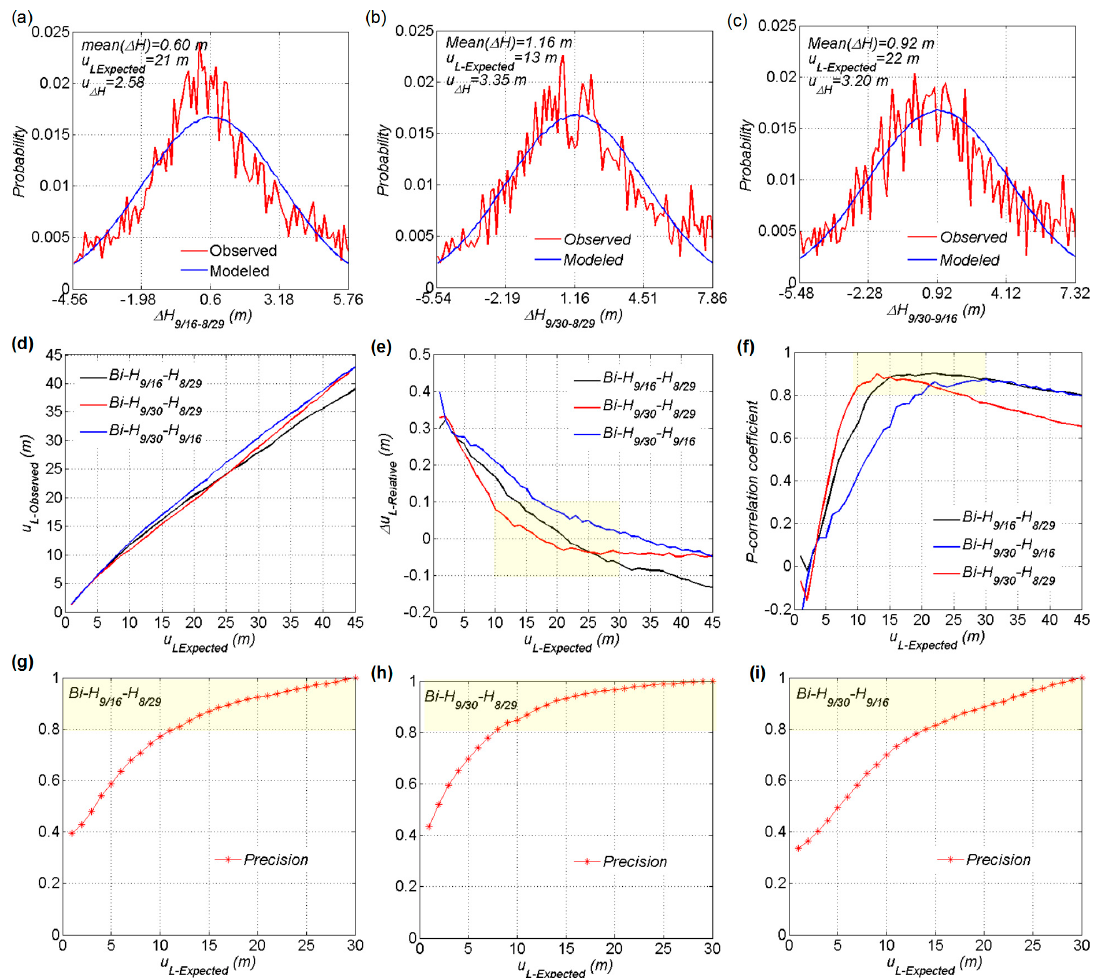
Δ H and a − 9/16 8/29 Δ H × 0.04 Δ ± 2 u in the interval of u H u at and 1- σ of Δ Δ Δ H H H